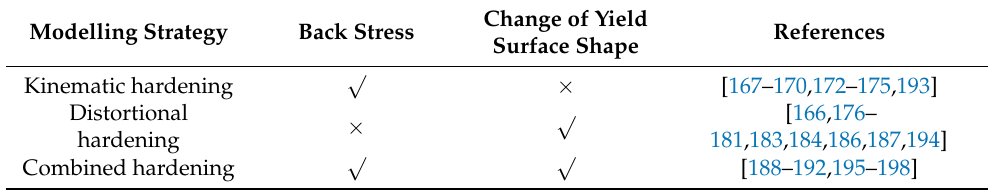
Table 3. Constitutive models to capture the Bauschinger effect under SPCs.